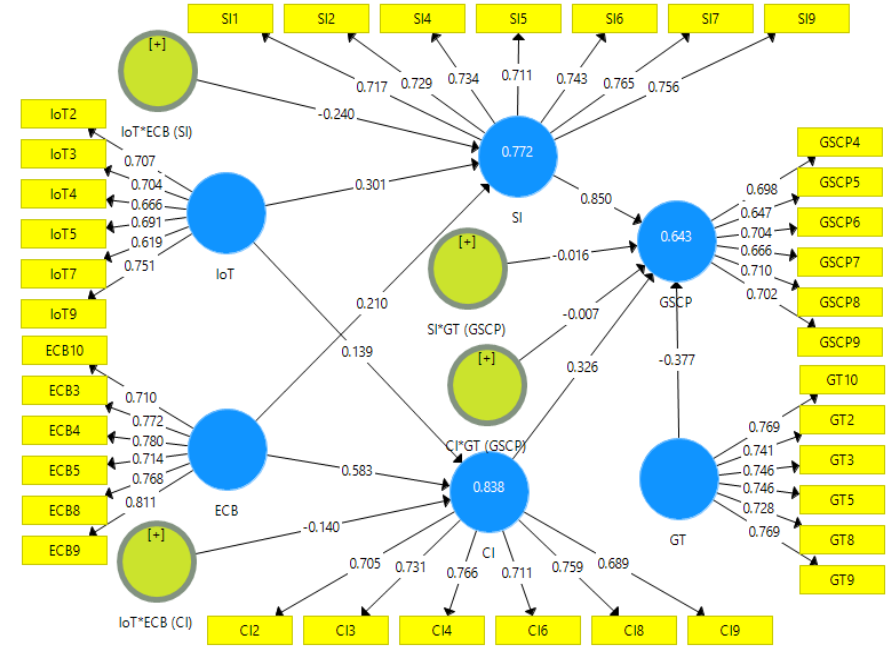
Figure 6. Path coefficients for green supply chain performance.